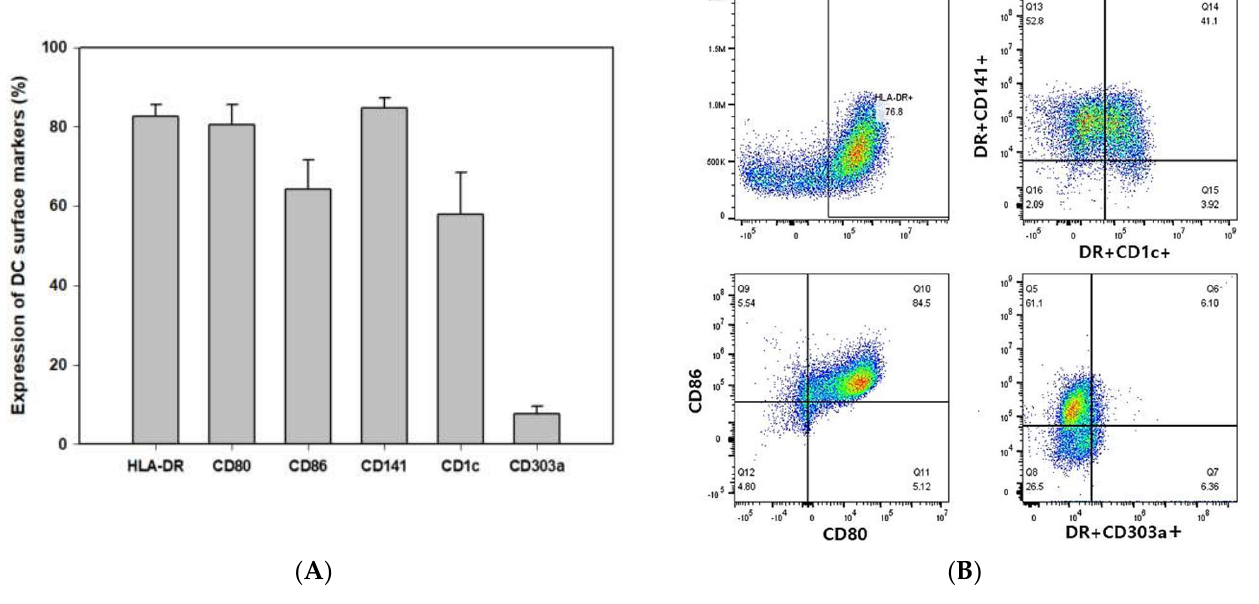
Figure 2. Identification of CDW subsets. Phenotypic characteristics of DC. During the differentiation process, the DC were pulsed with WT1 protein and treated with 1 μM zoledronate for 3 h. The data show the expression of stimulatory marker and subtype of DC representative of human DC (n = 5) ( A ). Results are shown as dot plots ( B ). Table 1. During the process of proliferation and differentiation from CD34+ cells to DC, phenotypic changes were analyzed using CBC.